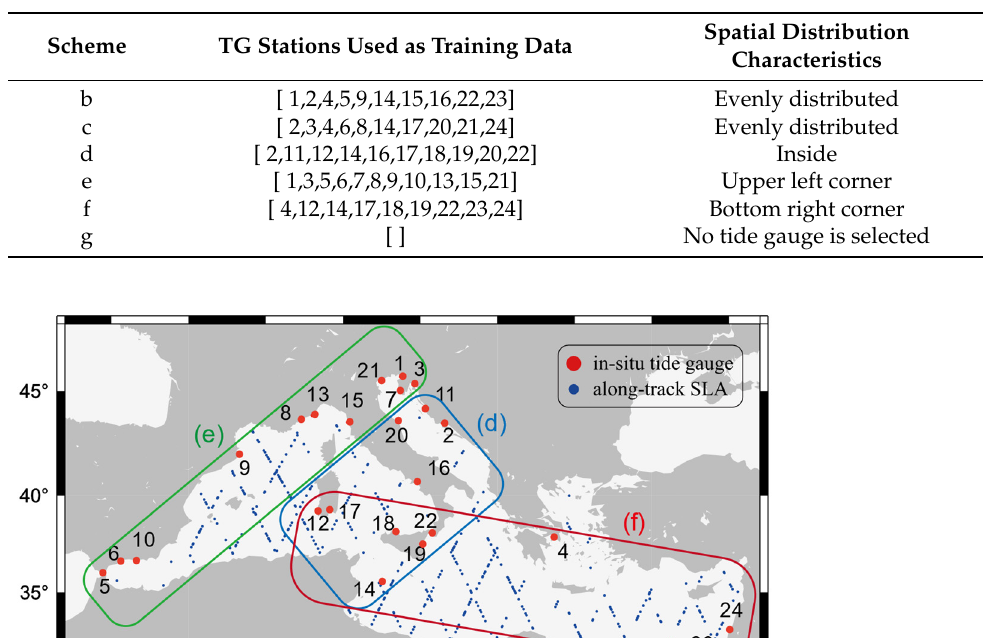
Table 3. Details of the six schemes of external control tide gauges.